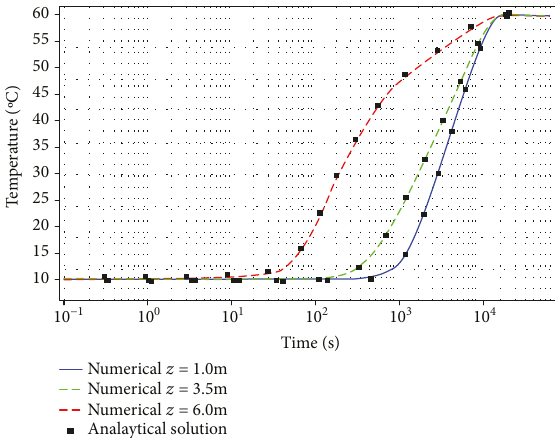
Figure 7: Temperature evolution with time at di ff erent positions within the soil column.